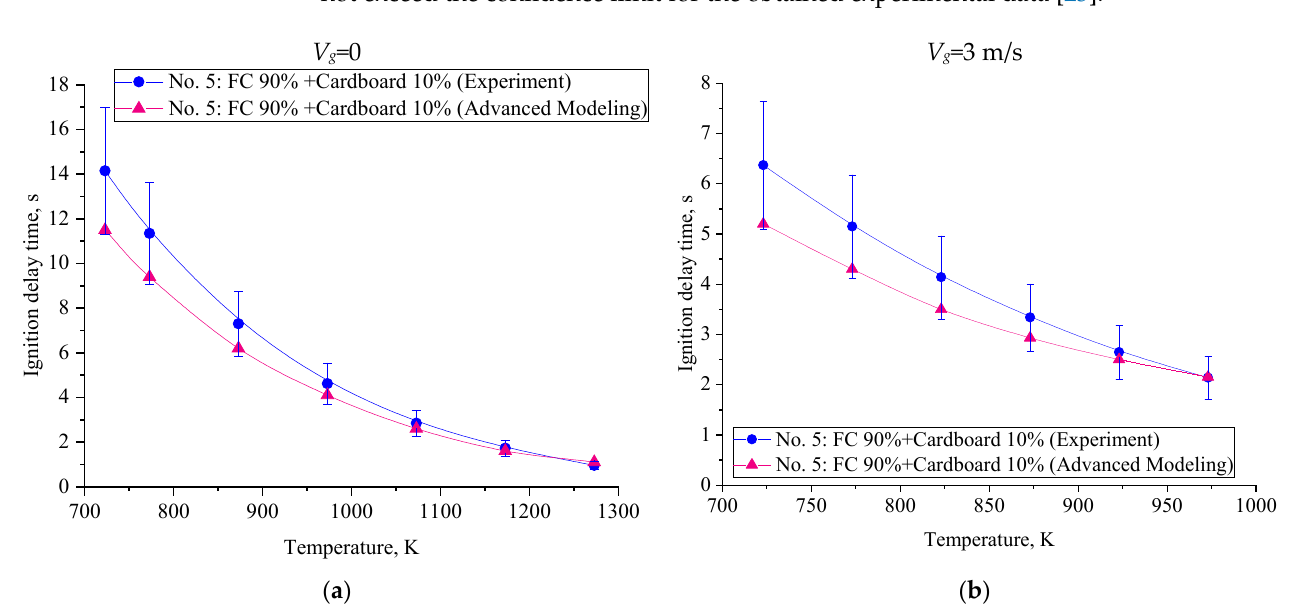
Figure 12. Ignition-delay times vs. heating source temperature for CLF composition No. 5 (FC 90% + cardboard 10%) at: ( a ) V g = 0; ( b ) V g = 3 m/s.